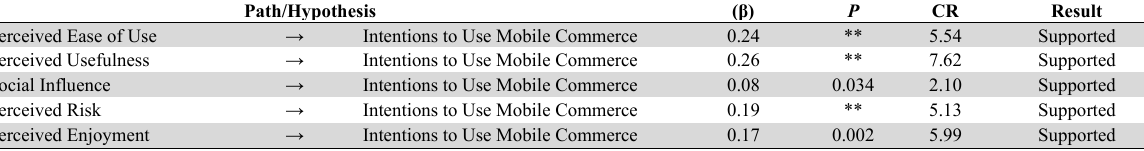
Hypothesis Testing